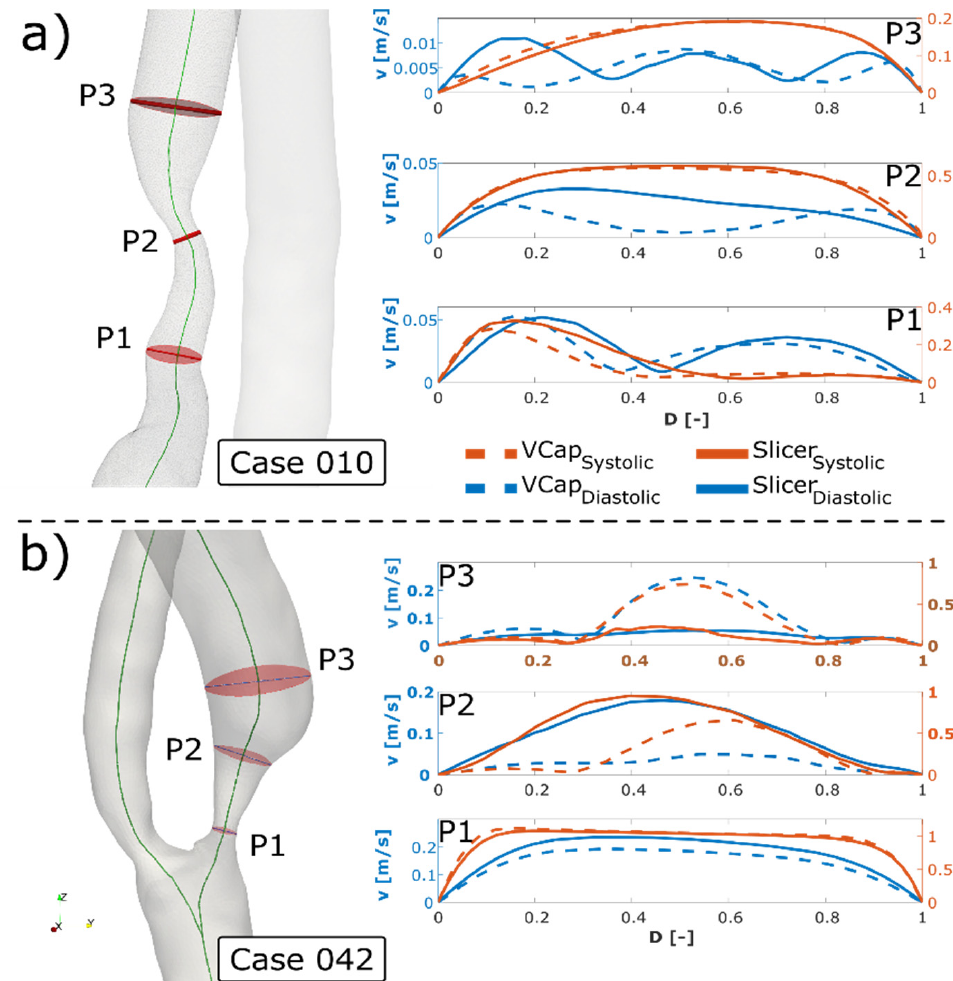
Figure 5. Results of the CFD simulations for Case 010 ( a ) and Case 042 ( b ). Velocity profiles extracted in the systolic and diastolic time instants are colored orange and blue, respectively. Dashed and continuous lines correspond to the VascuCap (semi-automatic) and Slicer (manual) geometries. The profiles are plotted along the non-dimensional diameter length. CFD: Computational fluid